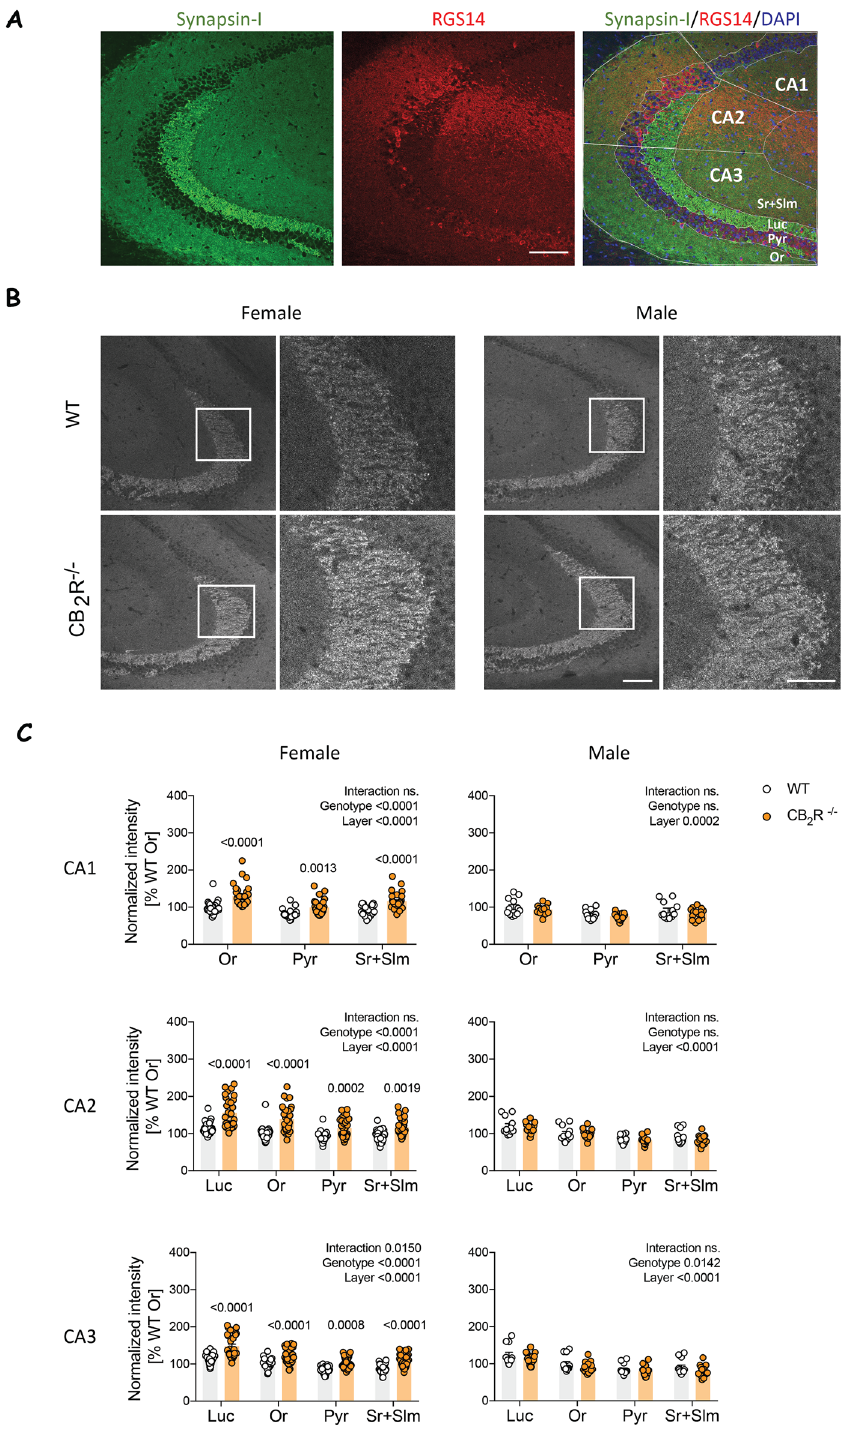
Figure 1. Synapsin-I levels are increased in the hippocampus after CB 2 R deletion in female mice. ( A ) Example images show synapsin-I (green), RGS14 (red) and DAPI (blue). White lines indicate manual delineation of CA regions and layers in the hippocampus. Scale bar: 100 µm. ( B ) Example images of synapsin-I immunoreactivity in male and female from WT and CB 2 R −/− mice. The white box within the left panel indicates the section that is displayed in higher magnification on the right. Scale bar: 100 µm, 50 µm (inset). ( C ) Quantification of synapsin-I mean grey value within each hippocampal layer normalized to the result from stratum oriens (Or). Or stratum oriens, Luc stratum lucidum, Pyr stratum pyramidale, Sr + Slm stratum radiatum and stratum lacunosum-moleculare. White circle—WT; orange circle—CB 2 R −/− mice. Each datapoint represents one image. Left panel—female mice (WT: n = 30 images from N = 9 mice; CB 2 R −/− : n = 31 images from N = 9 mice); right panel—male mice (WT: n = 12 images from N = 3 mice; CB 2 R −/− : n = 16 images from N = 4 mice). Top panel—CA1 region; middle panel—CA2 region; bottom panel—CA3 region. Data is displayed as mean value ± SEM. Data was analyzed by two- way ANOVA followed by Sidak’s multiple comparison test. The exact p-values are indicated on the graph and reported in Supplementary Table